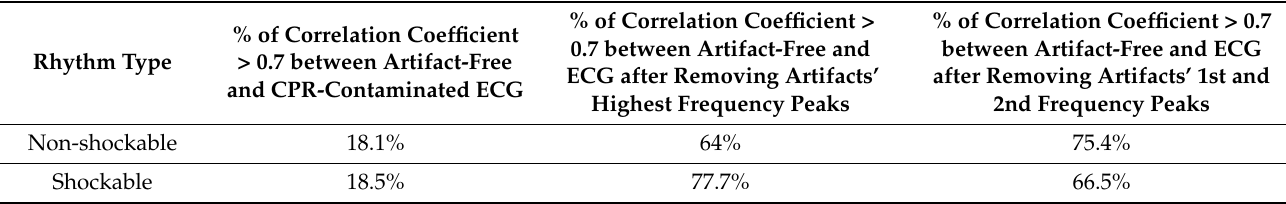
Table 1. Percentage of high correlation coefficient values between PSD of the artifact-free ECG and the corresponding corrupted and filtered signals.